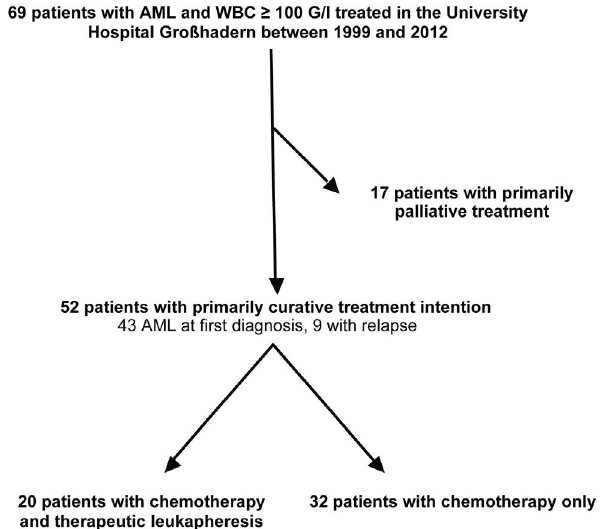
Figure 1. Overview of patient selection.